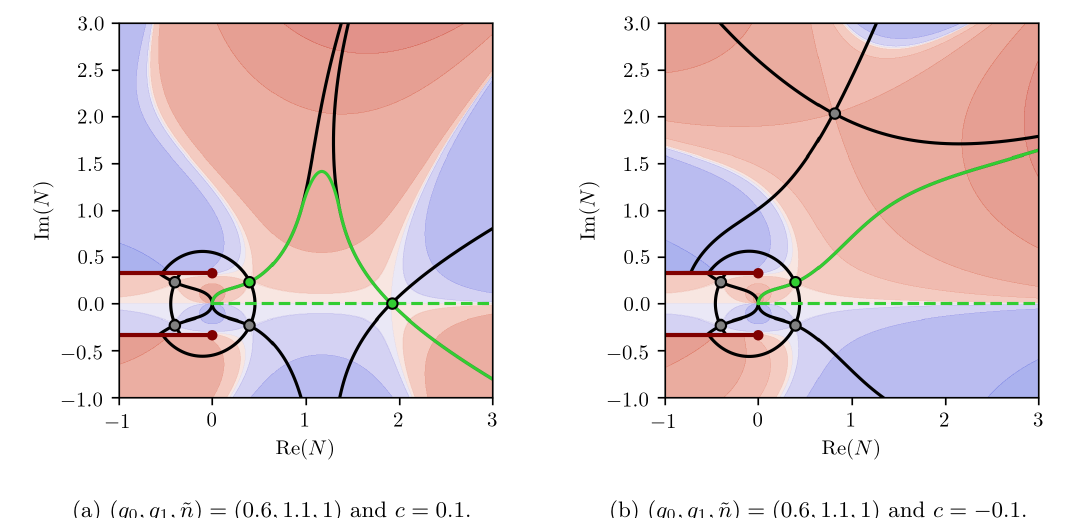
Figure 3. Structure of iS [ N, q + , n ; c ] in the complex- N plane for (a) c > 0 and (b) c < 0 . The new saddles of eq. (3.29) are far from the other saddles near the origin and can change the structure of the deformed contour for large | N | (cf. figure